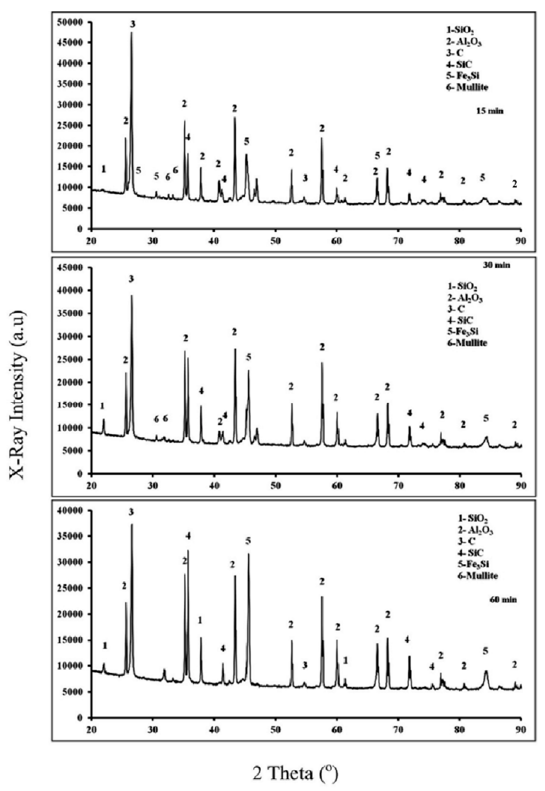
Figure 9. X-ray diffraction results from reacted assemblies after a range of reaction times. Phases present were identified as: (1) unreacted SiO 2 , (2) alumina, (3) carbon, (4) SiC, (5) Fe 3 Si, and (6) Mullite.